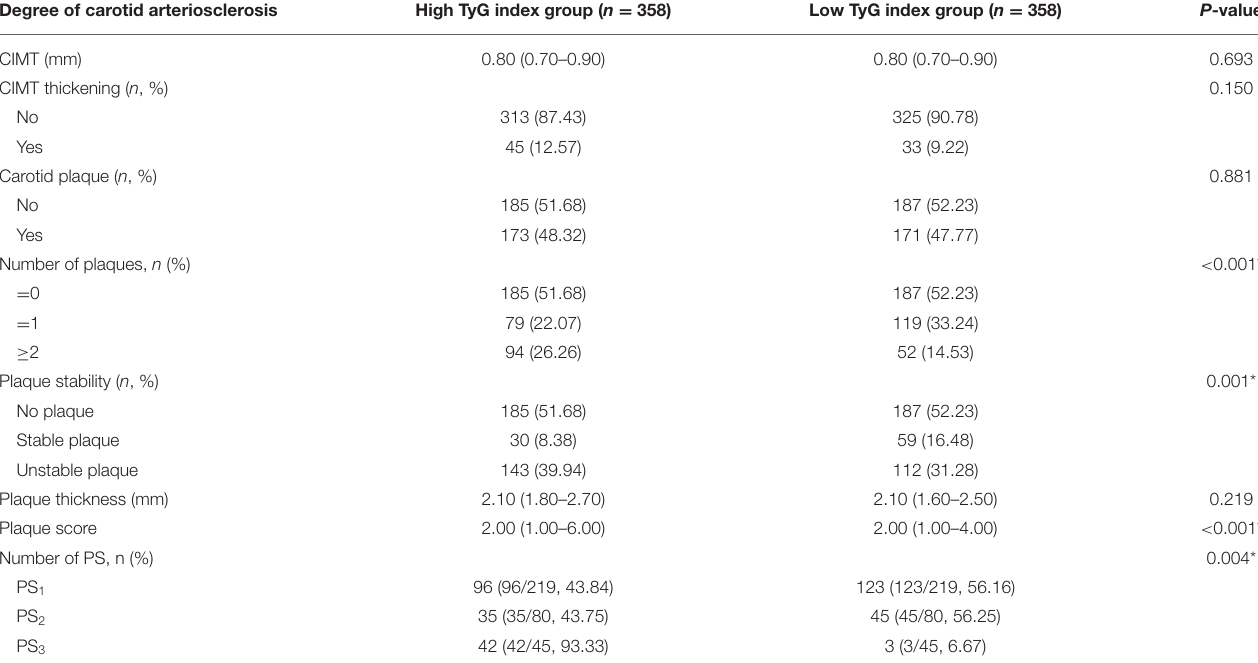
TABLE 2 | Degree of carotid arteriosclerosis of the subjects. Degree of carotid